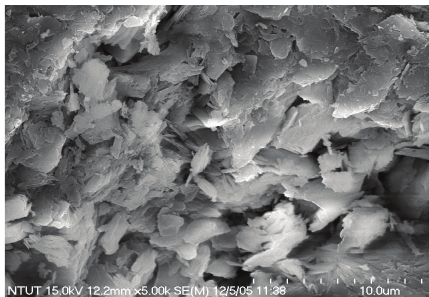
Figure 1: SEM microphotograph of